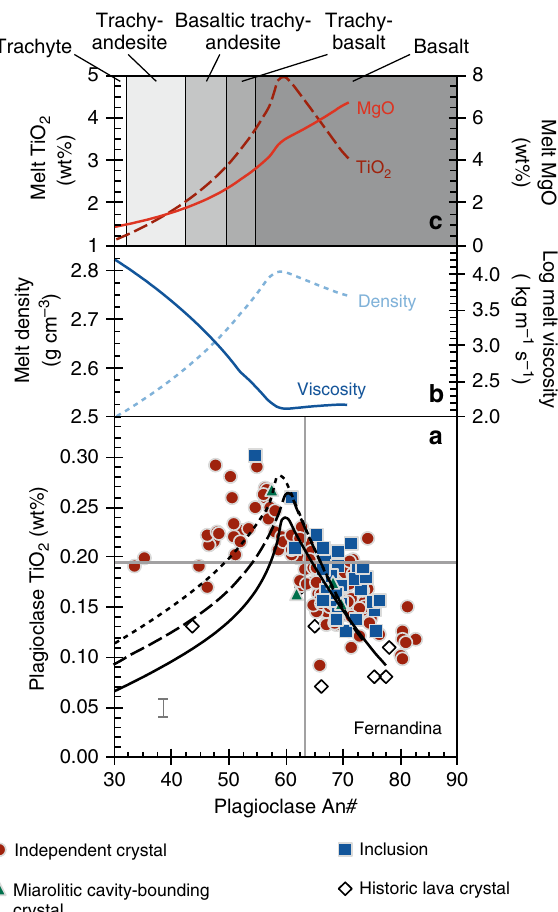
Fig. 7 TiO 2 in plagioclase model for the 2015 Wolf eruption. a Plagioclase TiO 2 vs. An# in lava and tephra samples from the 2015 Wolf eruption. Crystals are classi fi ed according to their textural association (see legend). Characteristic 2 σ analytical uncertainty is shown for TiO 2 and is less than the size of a data point for An#. The grey lines show the compositions of crystals calculated to be in equilibrium with the 2015 Wolf tephra glass (solid lines — average composition; dashed lines — 1 σ compositional range) 19 , using the models of Namur et al. 67 for An# and Nielsen et al. 43 for TiO 2 at 1160 °C (the approximate pre-eruptive crystallisation temperature) 19 . The black lines show the trajectory of plagioclase compositional evolution calculated using Rhyolite-MELTS and the TiO 2 partitioning model of Nielsen et al. 43 at 50MPa (solid line), 300MPa (dashed line) and 500 MPa (dotted line). Plagioclase comes onto the liquidus at 1214, 1229 and 1244°C in 50, 300 and 500 MPa models, respectively. The plots above show b the physical and c the compositional evolution of the liquid predicted by Rhyolite-MELTS at 300MPa (the approximate crystallisation pressure of the main magma storage zone at Wolf) 19